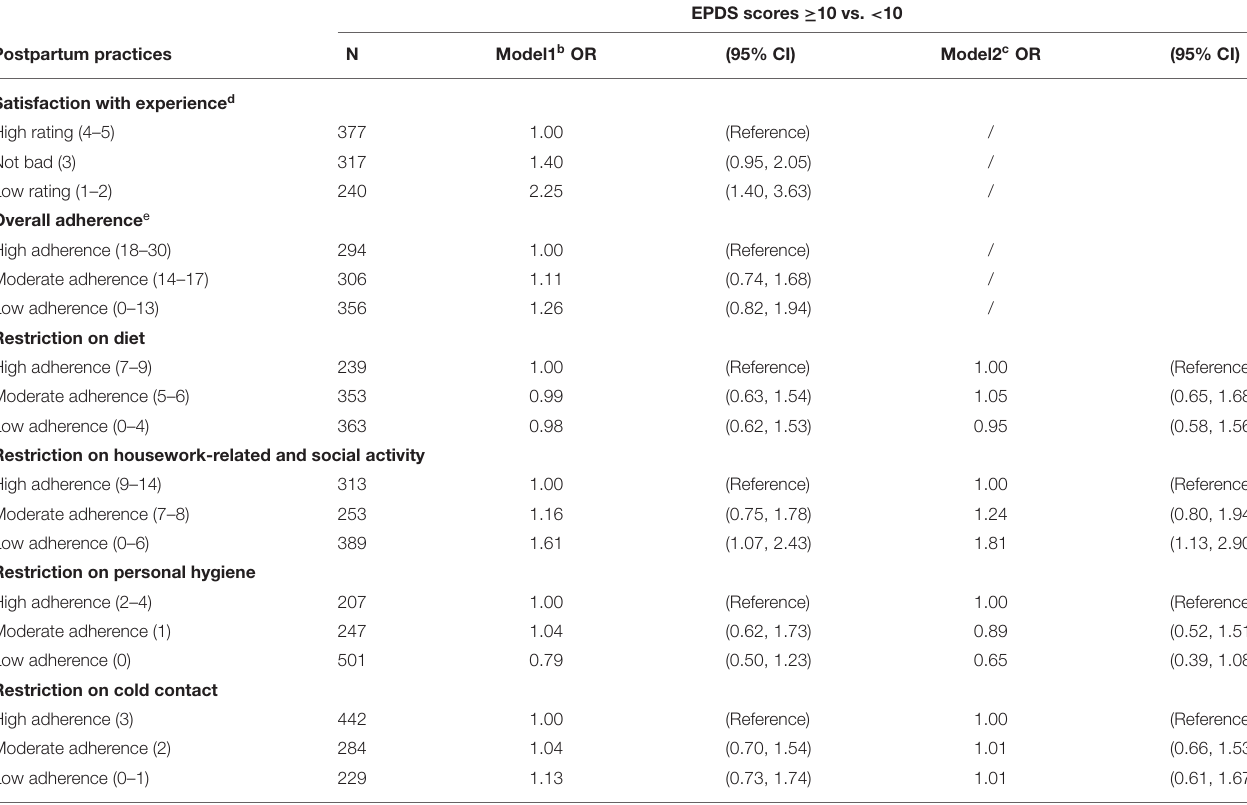
EPDS scores ≥ 10 vs. <